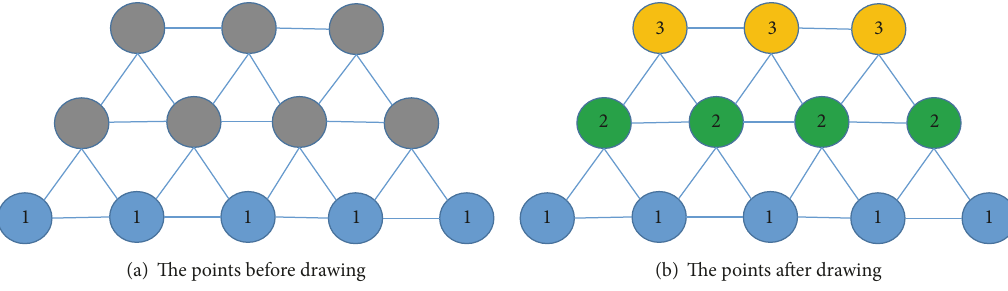
Figure 3: The abstract process of the proposed method.